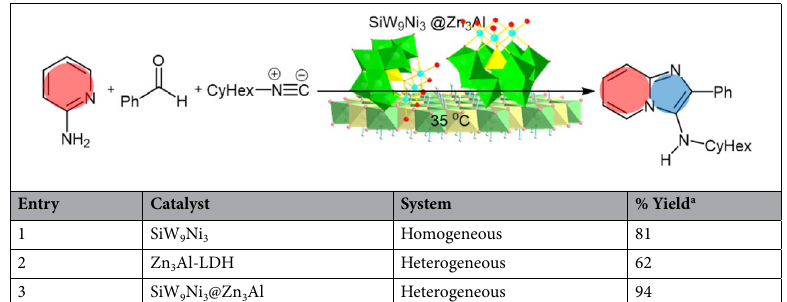
Table 1. Optimization steps on model reaction. Reaction condition: 1 mol% catalyst, 1 mmol of aminopyridine, 1 mmol of benzaldehyde, 1.2 mmol of cyclohexyl isocyanide, 35 °C, 1 h at solvent-free condition. a Isolated